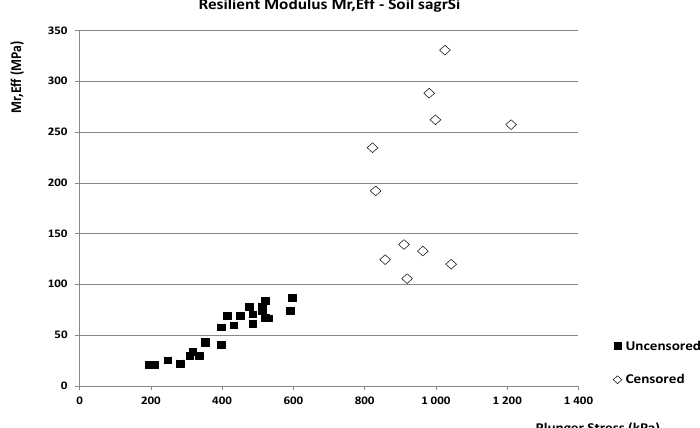
Figure 6. Resilient modulus M r,eff for soil csaCl.